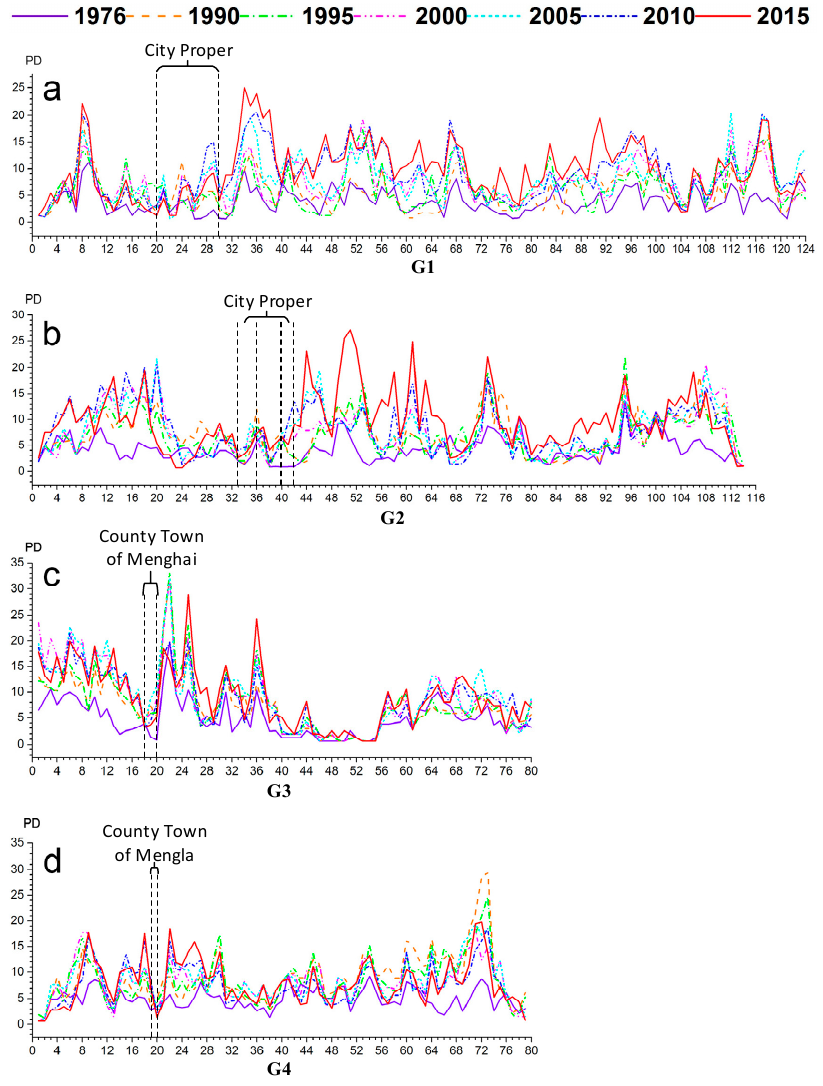
Figure 6. ( a – d ) Patch Density (PD) along four urban-rural gradients. X-axes represent the number of sampling blocks from the starting directions.